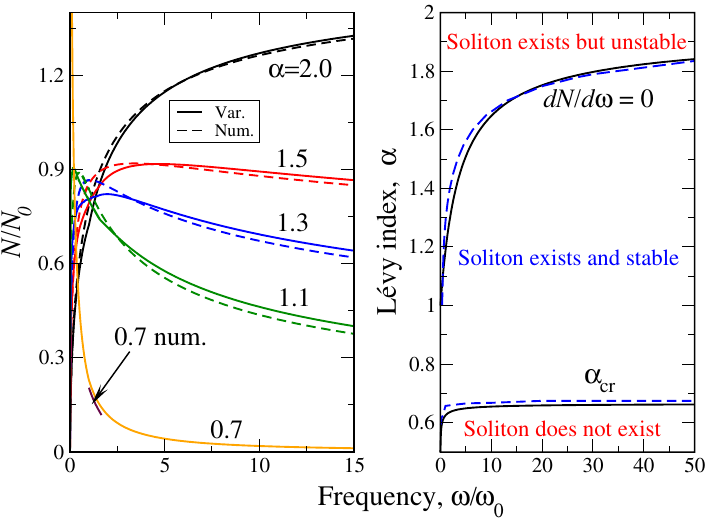
Figure 5. Comparison of numerical (dashed lines) and variational (solid lines) results for the soliton norm (left panel) and phase diagram (right panel). Due to numerical difficulties in the solution of the fractional equation (7) near the soliton existence boundary, only a small portion of the numerical curve N / N 0 (�) (labeled ”0.7 num.”) is